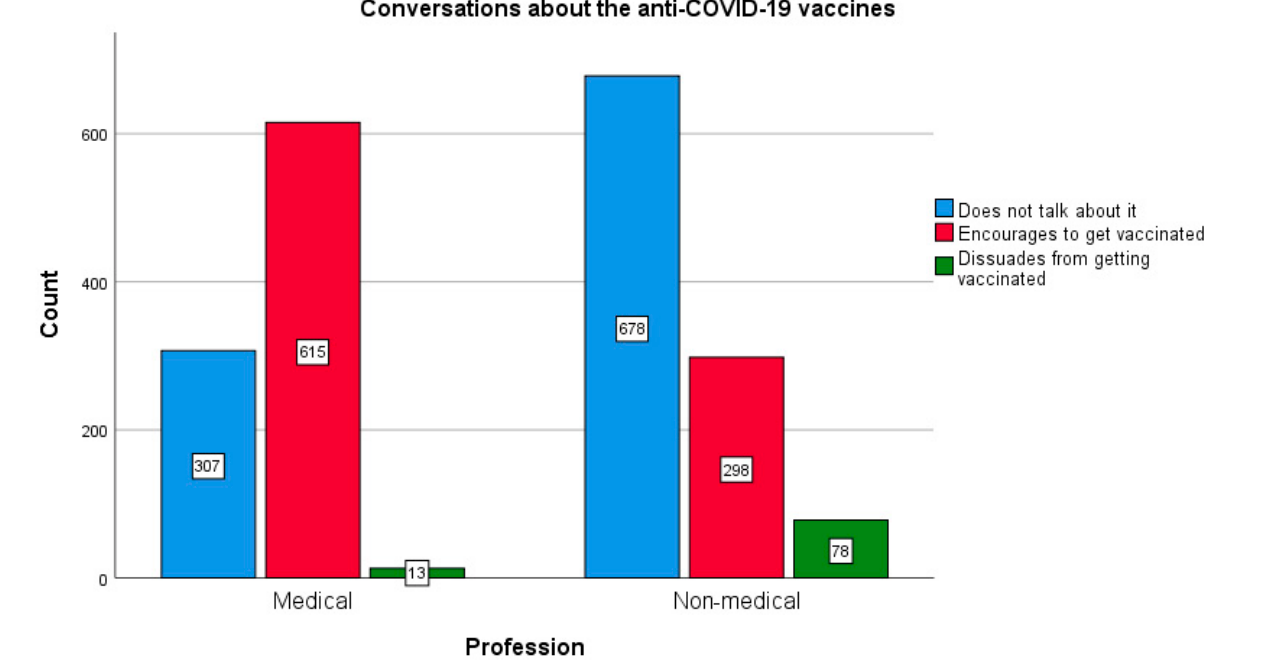
Figure 9. Differences in conversations on the COVID-19 vaccination between medical and non-medical professionals .